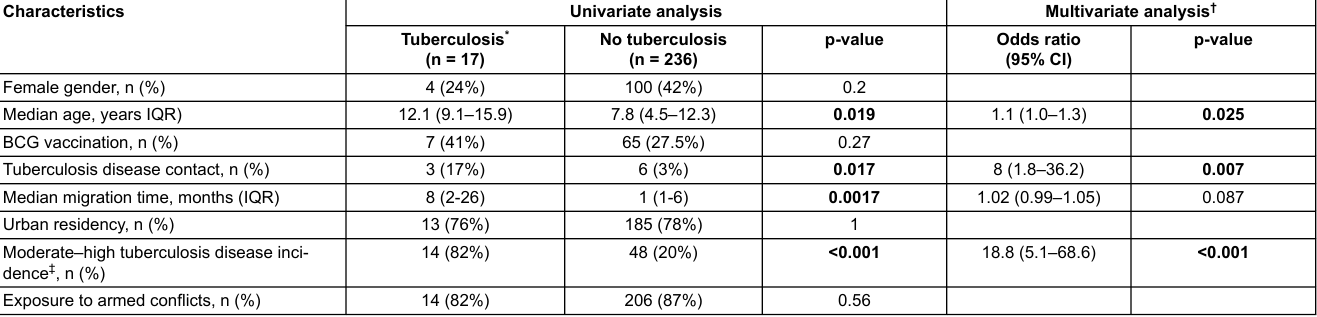
Table 3: Predictors of tuberculosis diagnosis (univariate and multivariate